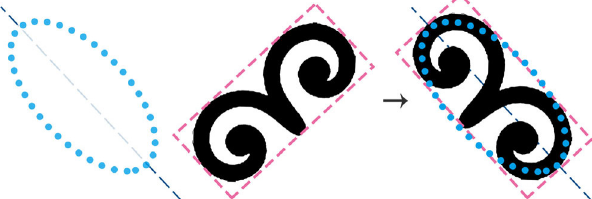
Fig. 4 For each ellipse (left), we find the best matching pattern (middle) and replace the ellipse by affinely transforming the pattern